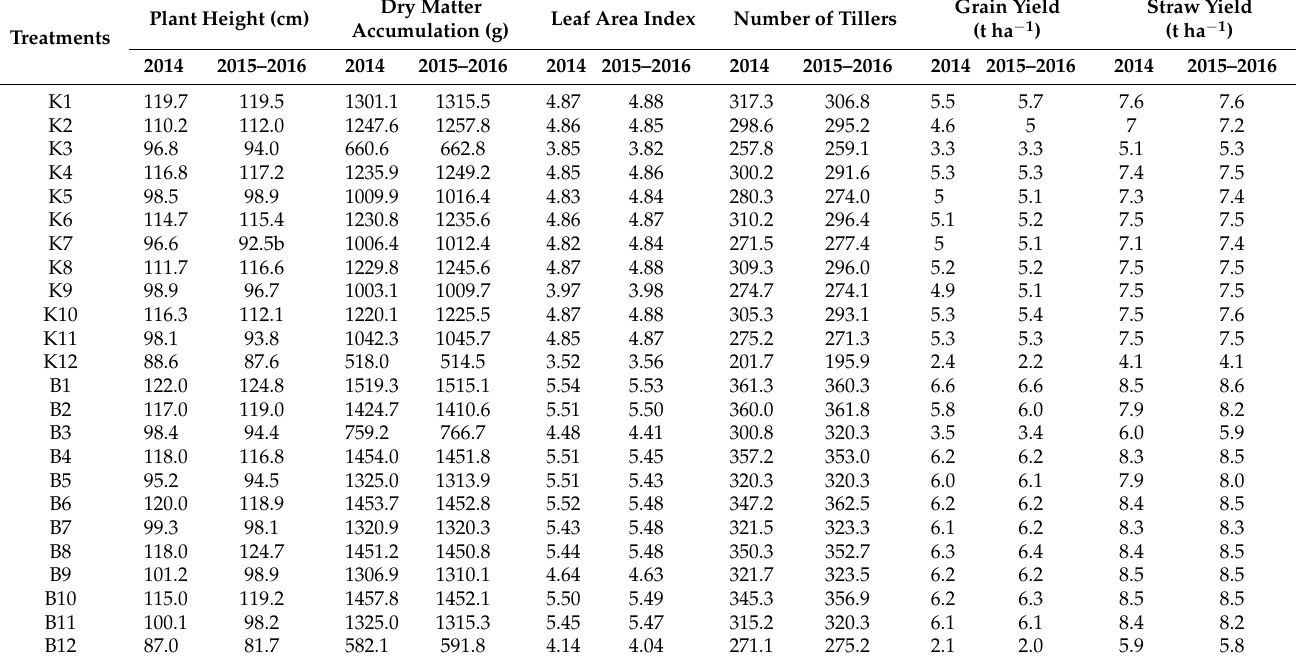
Table 4. Mean summary data of plant